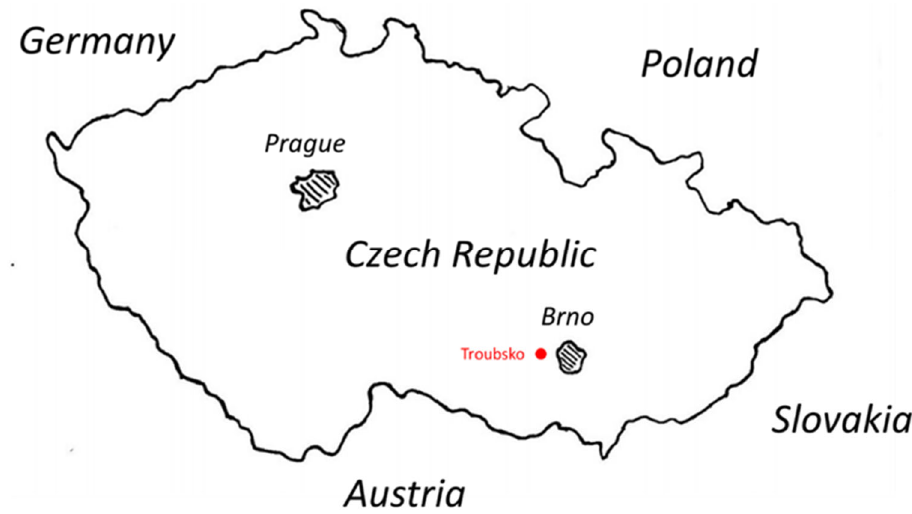
Figure 1. Localization of the Troubsko experimental field station in CZE (Czech Republic) and European Union. Table 1. Weather conditions at the Troubsko field experimental station, 2019 and 2020. Average monthly temperatures and mean annual precipitation amounts for long-term standard (1981–2010).